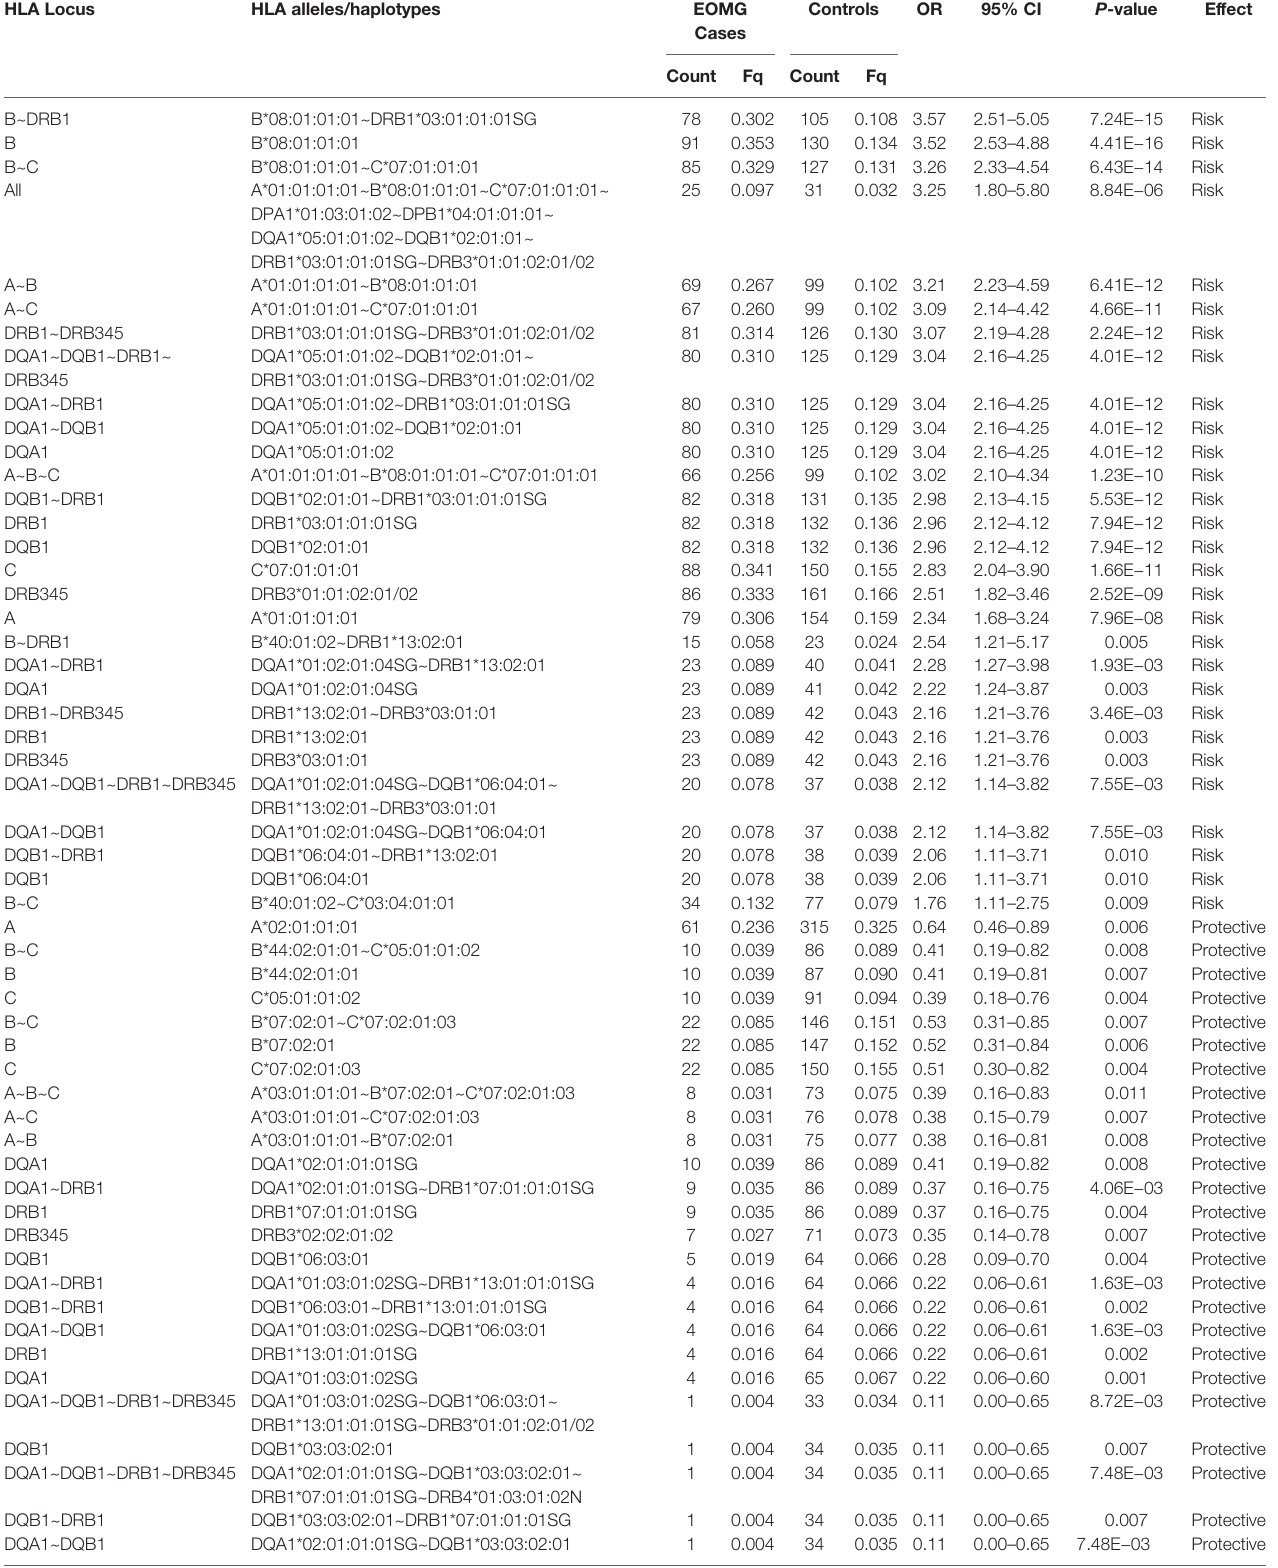
EOMG, early-onset Myasthenia Gravis; Fq, frequency; OR, odds ratio; CI, con fi dence interval; *, statistically signi fi cant P-values; P-values were not corrected for multiple-comparisons; Effect, effect of haplotype on disease